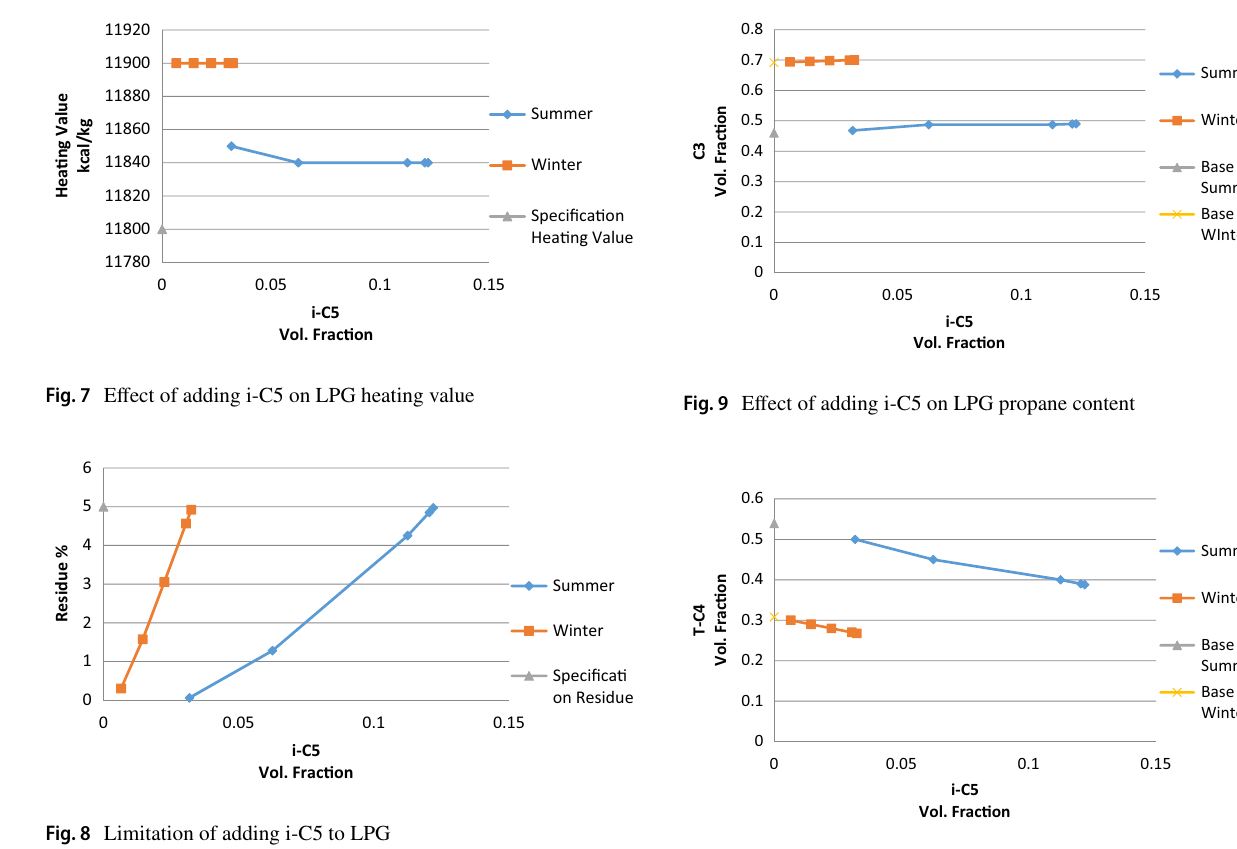
Fig. 10 Effect of adding i-C5 on LPG T-C4